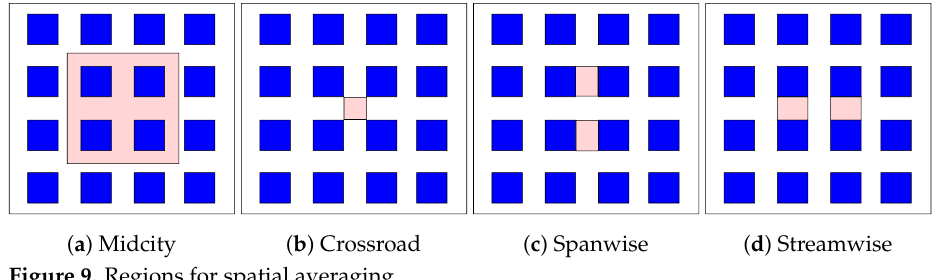
Figure 9. Regions for spatial averaging.